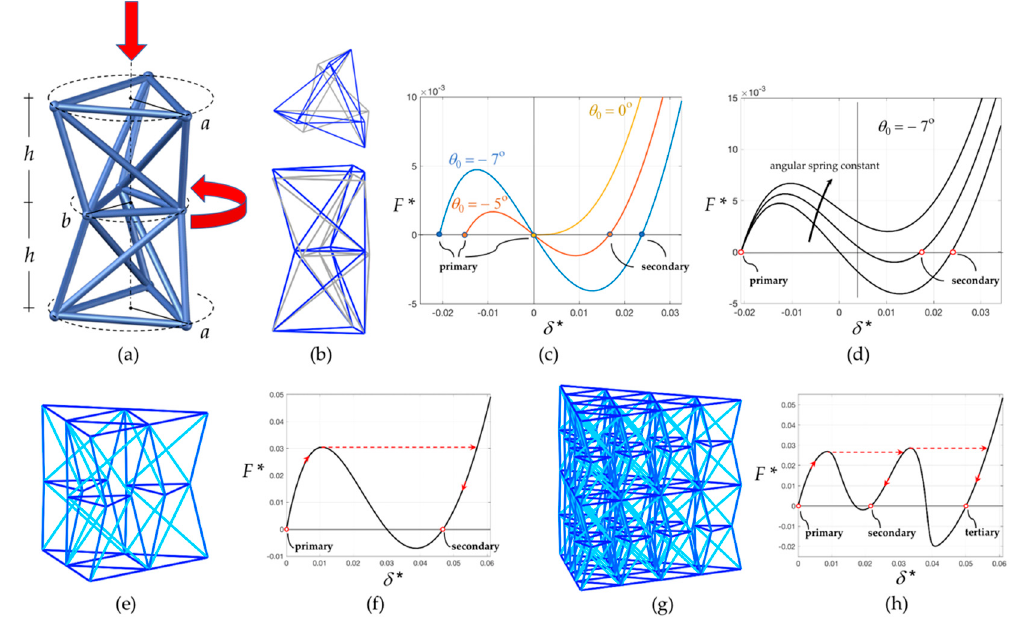
Figure 3. Mechanical modeling of the analyzed structures. ( a ) Geometry of the individual unit cell based on a double tensegrity prism. ( b ) Top view and side view of the primary (in blue) and secondary (in grey) stable configurations when the bistable mechanisms of the two prisms are activated simultaneously. ( c ) Static response of an individual unit cell with no angular springs under a vertical load for different values of the relative twist. ( d ) Static response of an individual unit cell with angular springs for different values of their spring constant. ( e ) Three-unit array. ( f ) Static response of a three-unit array. ( g ) Twenty-unit two-layer array. ( h ) Static response of a twenty-unit two-layer array.